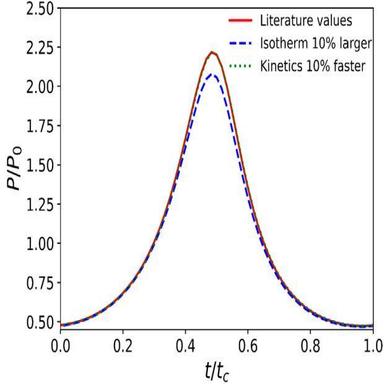
Pressure profiles of the CO2 simulation runs in the packed bed with different isotherm and kinetic parameters. Conditions: T0 = 30 C; u = 0; Stroke1 = Stroke2 = 0–100 mm, tc = 20 s.